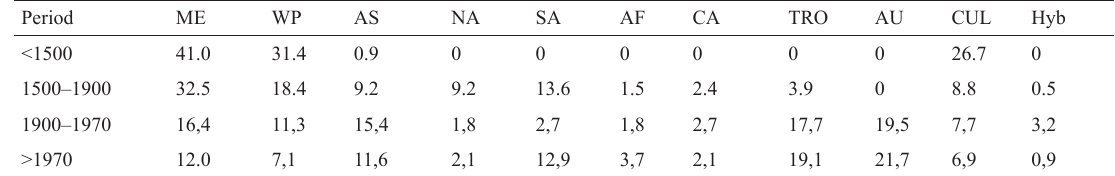
Table 1. Proportional contribution (%) of the introduced plants in Catalonia according to their origin in different temporal periods. ME: Mediterranean; WP: Western Paleartic; AS: Eastern and Southern Asia; NA: North America; SA: South America; AF: Tropical Africa; CA: South Africa; TRO: Tropical and Subtropical regions; AU: Australasia; CUL: Cultivated; Hyb: Spontaneous